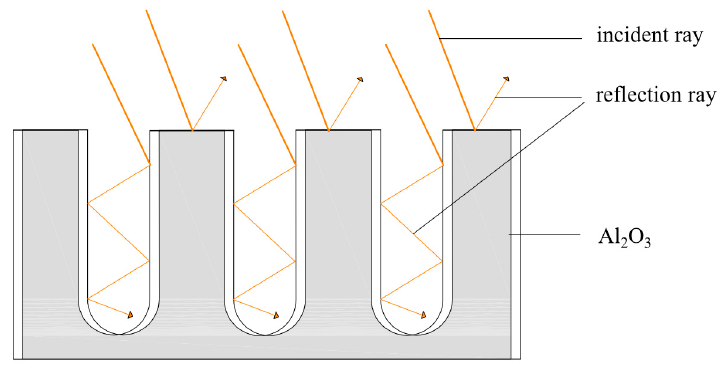
Figure 1. Schematic of the nanoporous alumina sheet.